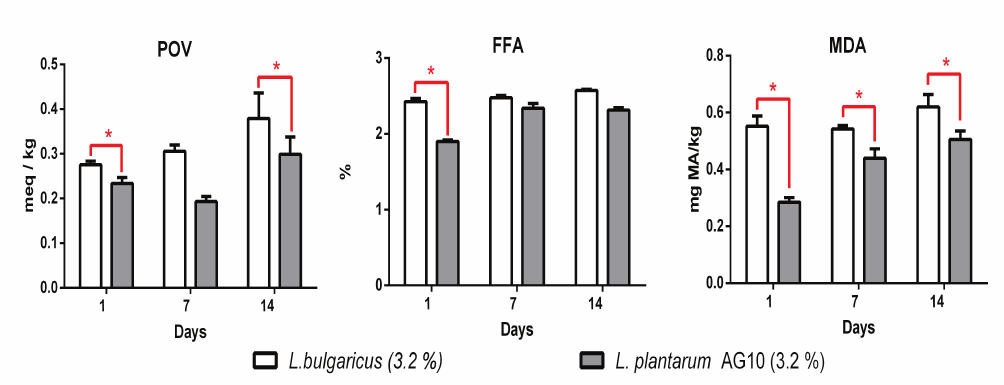
Figure 5. Radical-scavenging ability of protein-free extracts (PFE), whey, and whole fermented milk obtained with either L. bulgaricus (shown in white) or L. plantarum AG10 (shown in gray) measured in radical-scavenging ability (RSA) with the DPPH assay after 1, 7, and 14 days of storage. Asterisks show a significant difference at p < 0.05. The % of initial fat in the milk is shown under the x-axis.